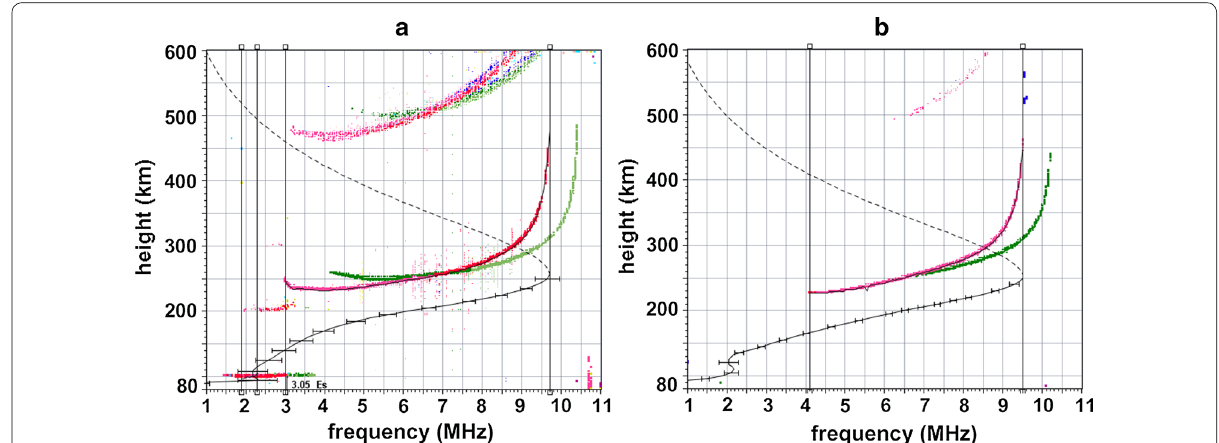
Fig. 6 Ionograms recorded by DPS‑4 in Pruhonice just before the X‑ray flare at 14:00 UT a and during the X‑ray flare at 14:15 UT, b on 22 October 2014. Virtual reflection heights of ordinary L‑O mode waves are by red, virtual reflection heights of extraordinary R‑X mode waves are by green, and true reflection heights are by black